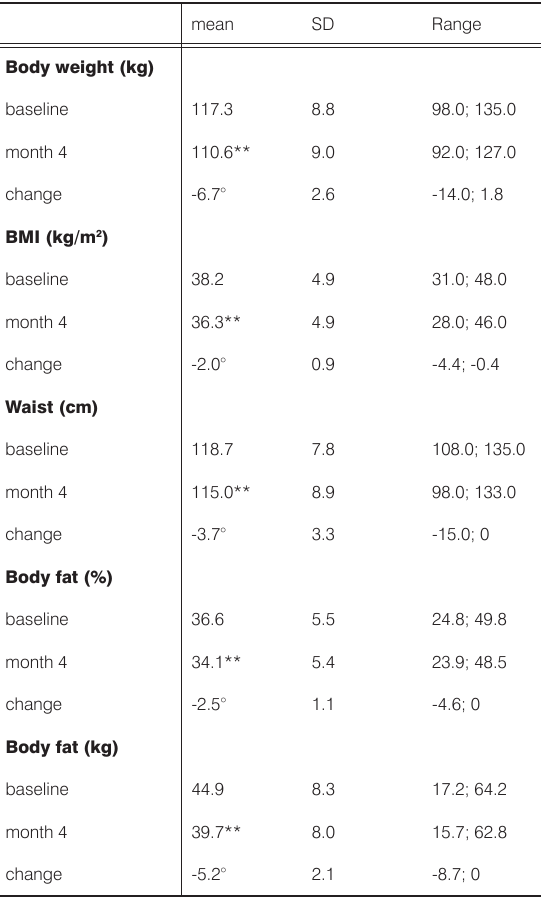
Table 2. Changes in anthropometric parameters, the control group (n = 49) mean SD